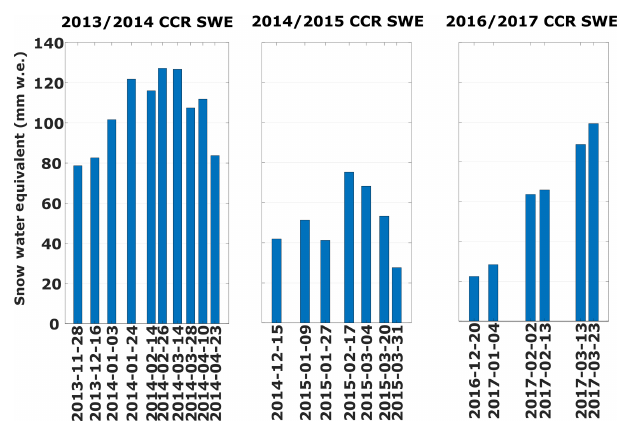
Figure 7. Caribou Creek SWE observations by date for 2013/2014, 2014/2015, and 2016/2017. “mmw.e.” refers to millimetres of water equivalent.